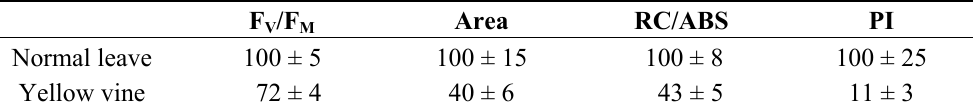
Table 4. Photosynthetic parameters of yellow vine syndrome and normal cranberry leaves; PSII maximum quantum yield (Fv/Fm), the size of quinone pool (Area), the numbers of reaction center per absorption cross section (RC/ABS), and the photosynthesis performance index (PI). F /F V M